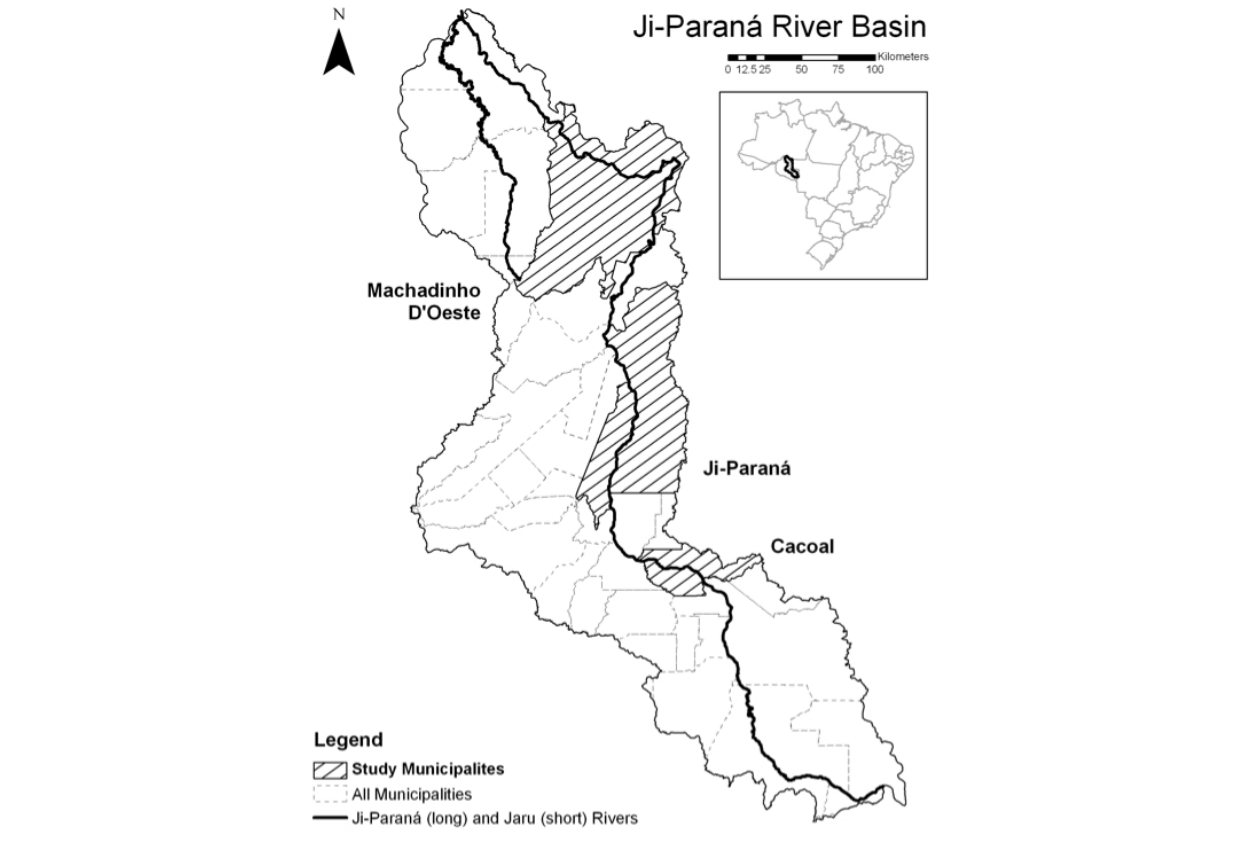
Fig. 1. Ji-Paraná River